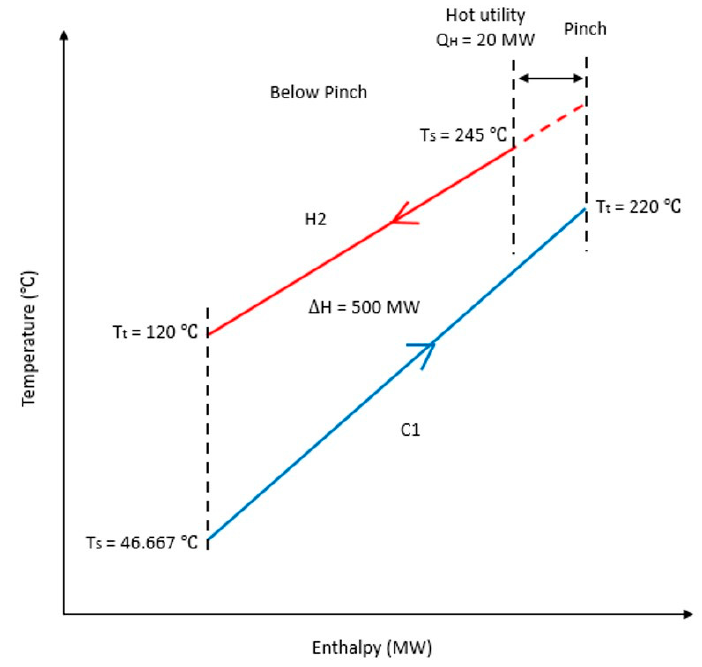
Figure 7. The plus-minus principle with decreasing T S by 5 ℃ for hot stream H2 at HE4. Observation 3. Increasing T S for a hot or cold stream below the pinch results in increasing Q C .